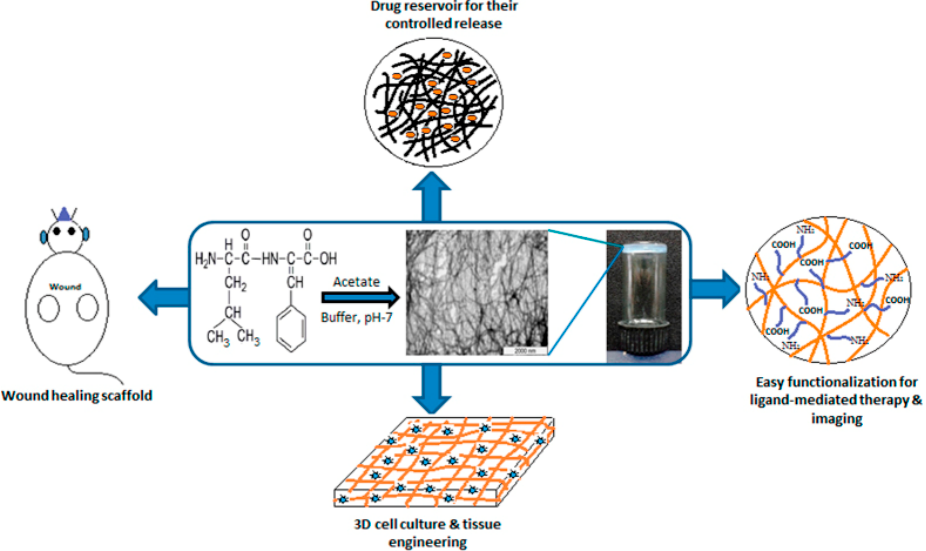
Figure 9. Self-assembling of L Δ F dipeptide and their applications in the biomedical field. Adapted with permission from Reference [149].